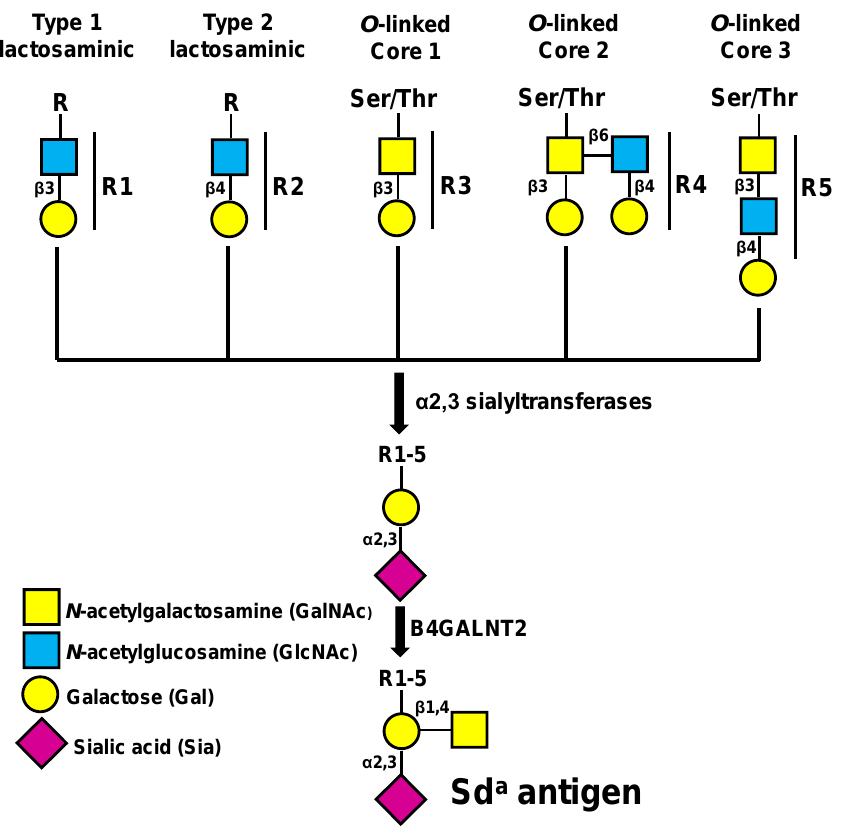
Figure 1. Schematic representation of the structure and biosynthesis of the Sd a antigen. Several carbohydrate structures (R1–R5) terminating with galactose are α2,3 sialylated by different α2,3 the Sd a sialyltransferases. The resulting sialylated structure is a substrate for B4GALNT2, which generates the Sd a antigen.